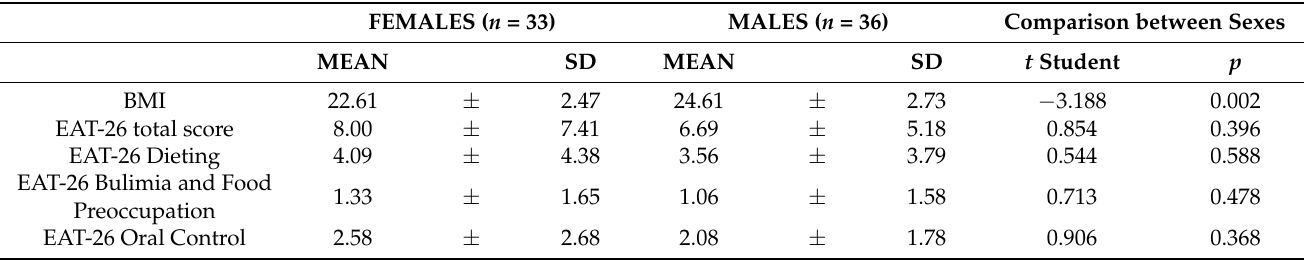
Table 1. Beach-handball players descriptive and comparison (males vs. females). FEMALES ( n = 33) MALES ( n = 36) Comparison between Sexes MEAN SD